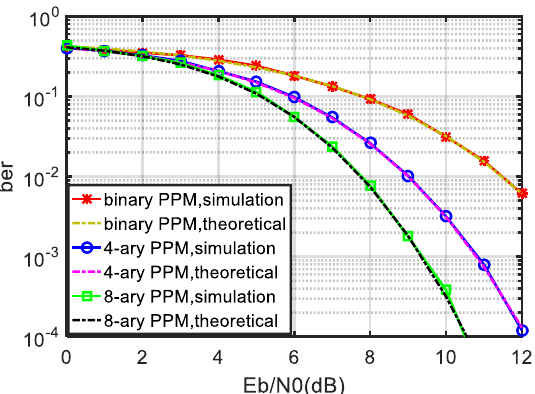
Figure 6. BER performance of noncoherent PPM suboptimal